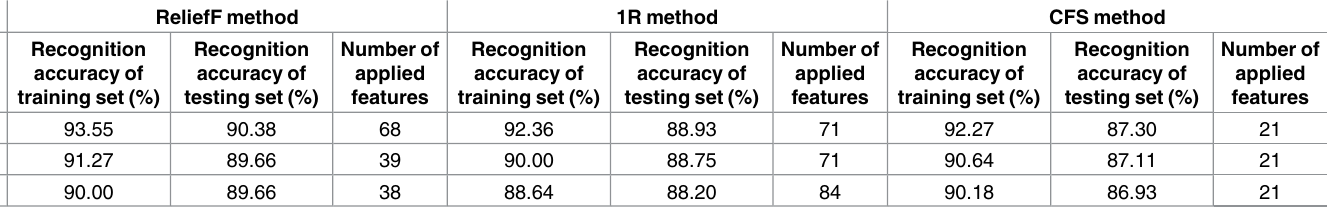
Note: Only the best KNN model for the image recognition of the four alfalfa leaf diseases is shown when the features were selected using the ReliefF method or 1R method.